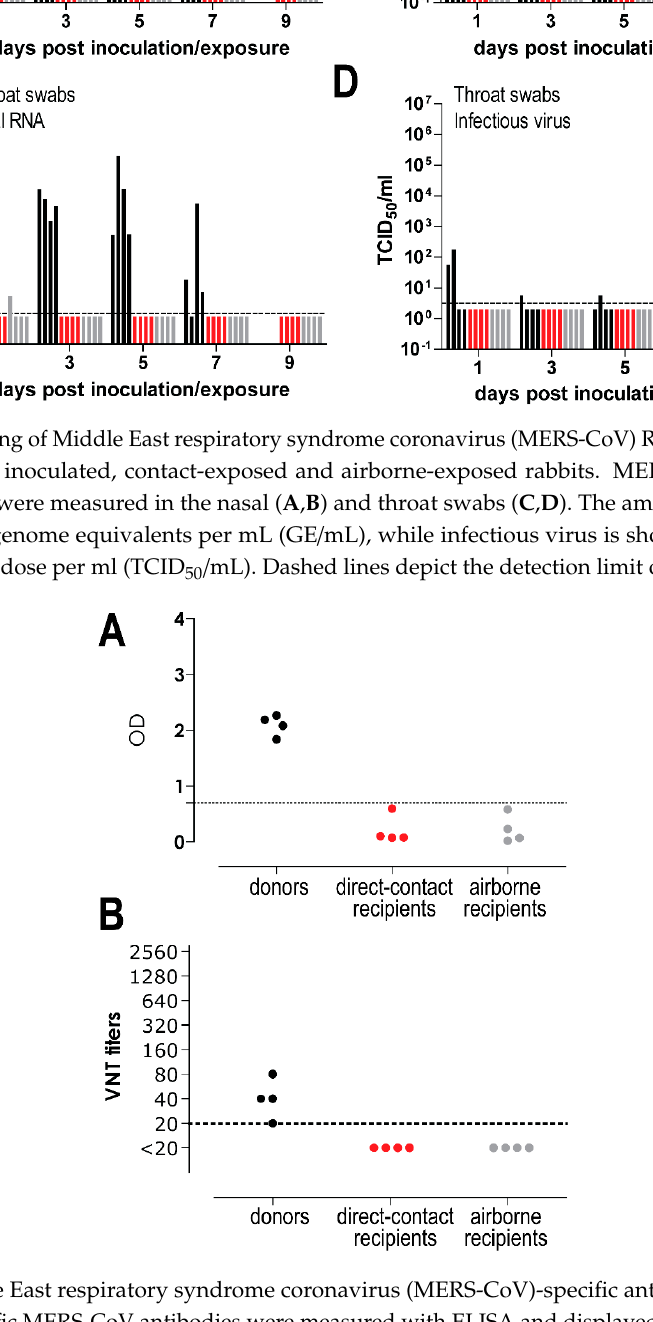
Figure 6. Middle East respiratory syndrome coronavirus (MERS-CoV)-specific antibody response in rabbits. S1-specific MERS-CoV antibodies were measured with ELISA and displayed as optical density (OD) value ( A ), while MERS-CoV neutralizing antibodies were measured with the virus neutralization test (VNT) and displayed in titers ( B ). Dashed lines depict the detection limit of the assay.